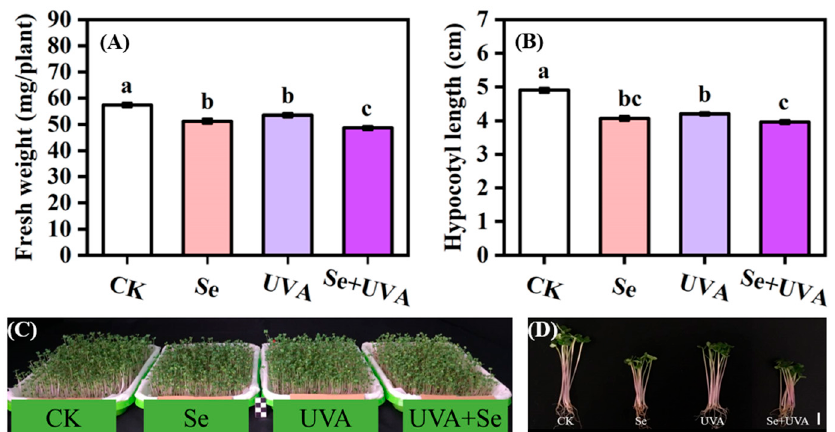
Figure 1. Fresh weight ( A ), hypocotyl length ( B ), and photos ( C, D ) of broccoli microgreens under Se (100 μ mol/L Na 2 SeO 3 ), UVA (40 μ mol/m 2 /s), and combined treatments. The vertical bars indicated standard errors, n = 18 ( A ) or n = 39 ( B ). Different lower-case letters above the bars indicated significant differences between treatments by Duncan’s multiple range test at a level of 0.05. Photos of broccoli microgreens ( C, D ) were taken at 7 days after sowing, where the bars represent 1 cm.